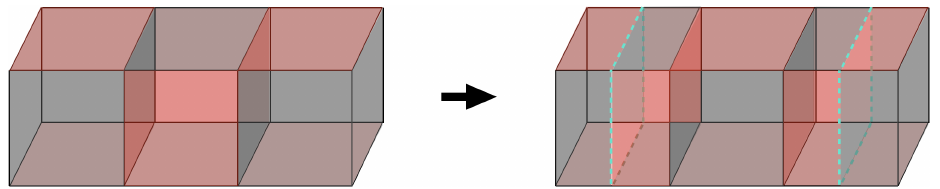
Figure 31 . Triality on an intermediate brick of an n -cube model. Eight 2-valent edges (shown as dashed lines), i.e. mass terms, are generated during this process. To avoid confusion, it is important to emphasize that there are no vertical faces suspended from the dashed edges.